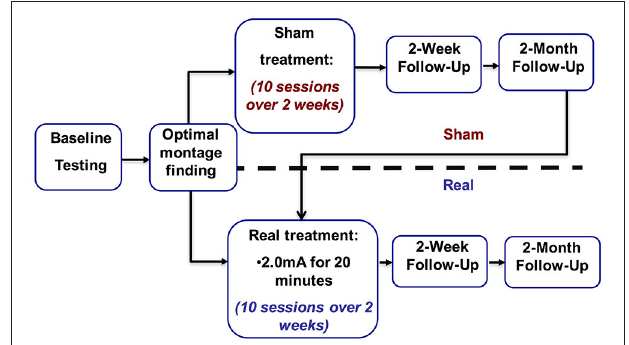
FIGURE 1 | Study overview.